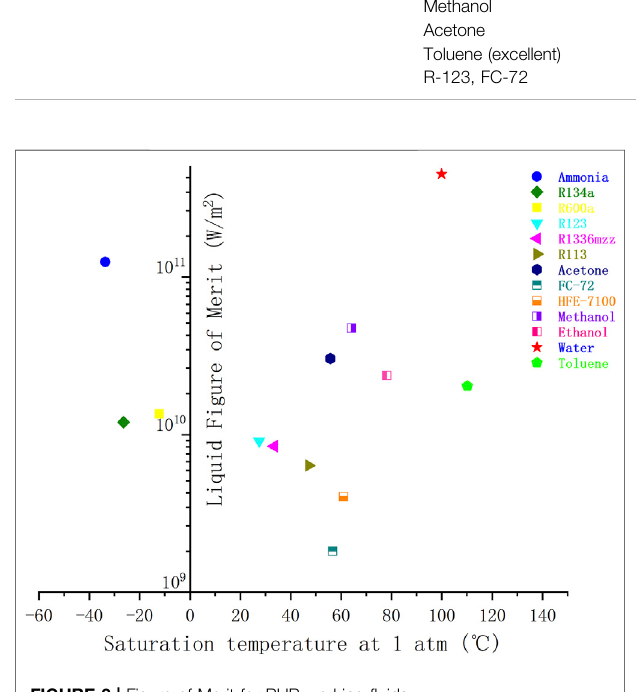
FIGURE 3 | Figure of Merit for PHP working fl